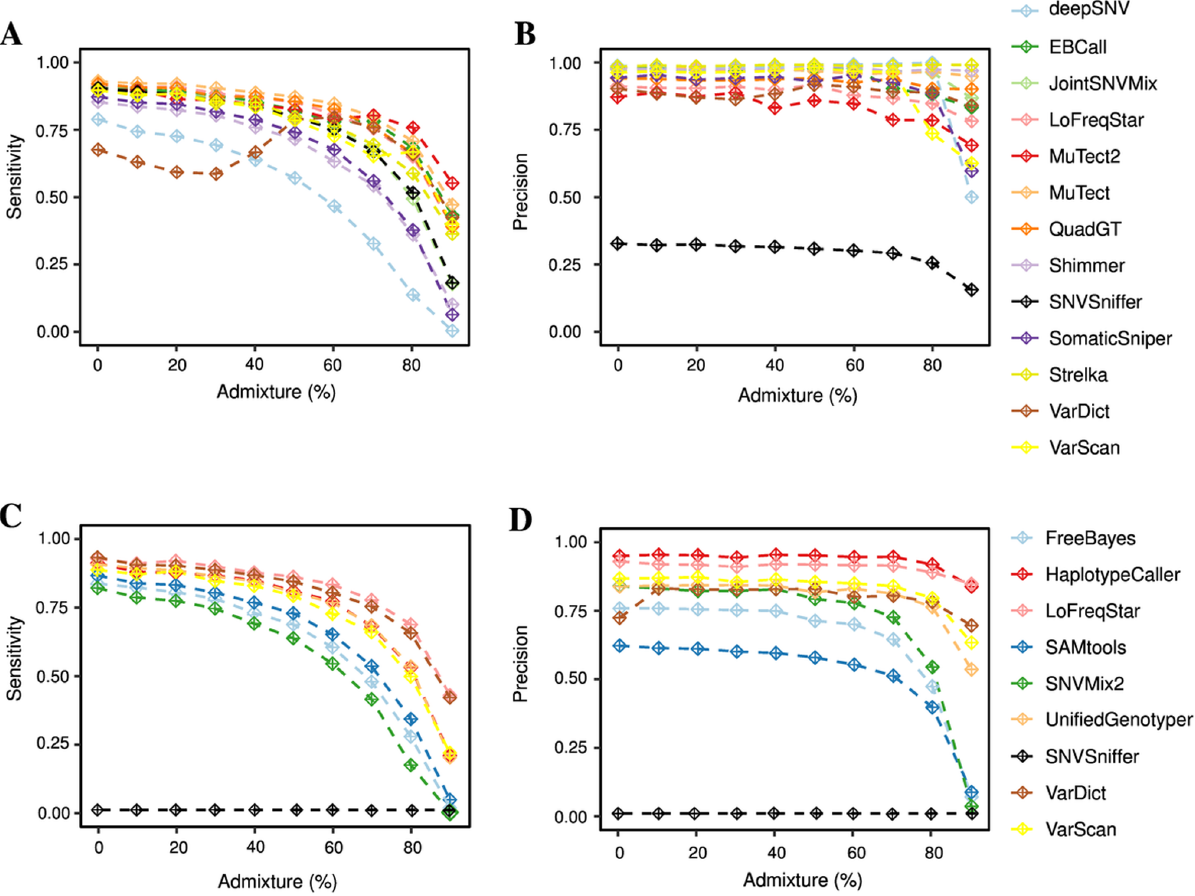
Fig 4. Benchmarking results for somatic SNVs on exome data. A and C. Sensitivity; B and D. precisionfor somatic SNVs. A, B. on pairedtumor-control exome data; C, D. on single tumor exome data.